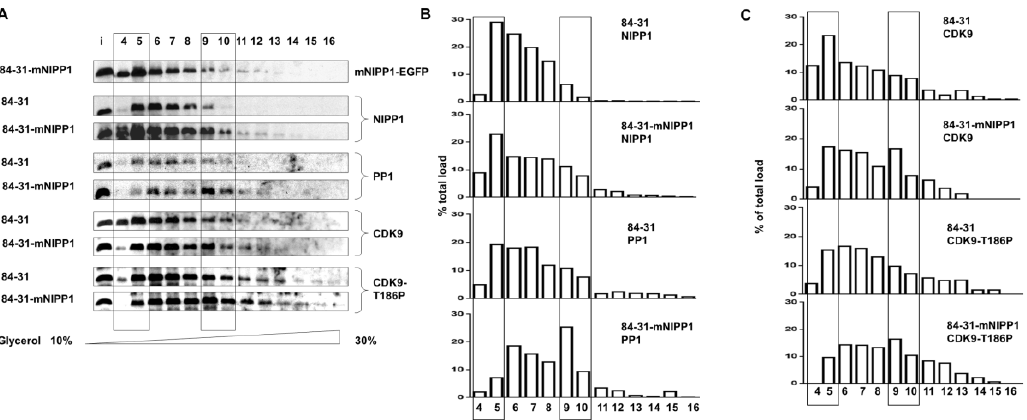
Figure 4. Stable expression of mNIPP1 induces CDK9 phosphorylation and changes in CDK9 and PP1 distribution. ( A ) Western blot analysis of extracts fractionated on glycerol gradients. Whole cell extracts from 84-31 and 84-31-mNIPP1 cells were separated by ultra-centrifugation on glycerol gradient (10%–30%). Fractions were collected, precipitated and resolved on 10% SDS-PAGE, and further analyzed by Western blot with antibodies against EGFP, NIPP1, PP1, CDK9 and CDK9 phosphorylated on Thr-186. Direction of the glycerol gradient is indicated; ( B ) Quantification of NIPP1 and PP1 migration from panel A. Protein expression is shown normalized to total protein load; ( C ) Quantification of CDK9 and CDK9 phosphorylated on Thr-186 migration from panel A. Protein expression is shown normalized to the total protein load.